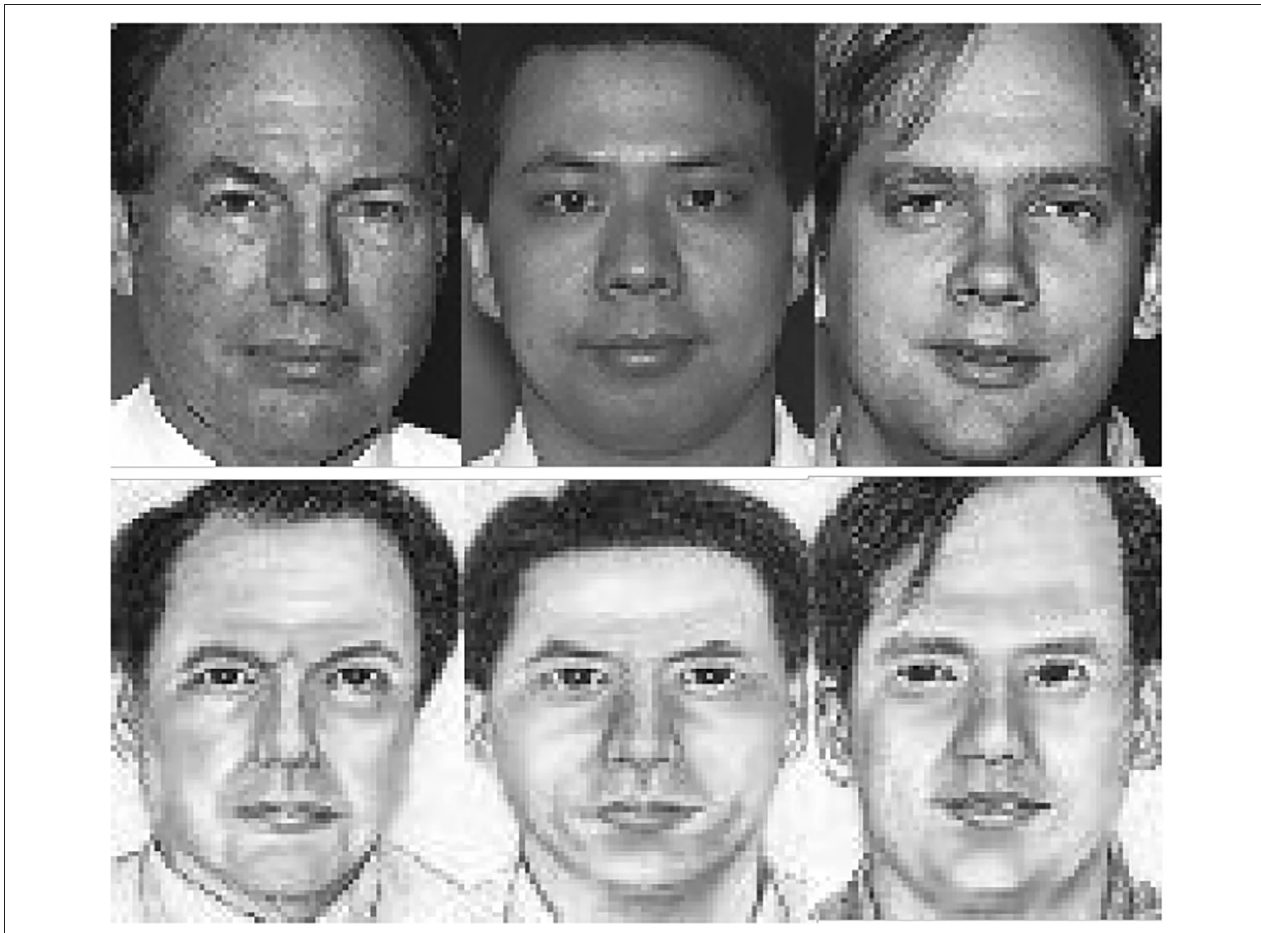
FIGURE 4 | Examples of cropped images from the CUFSF dataset, the top and bottom row are photo and sketch images, respectively.